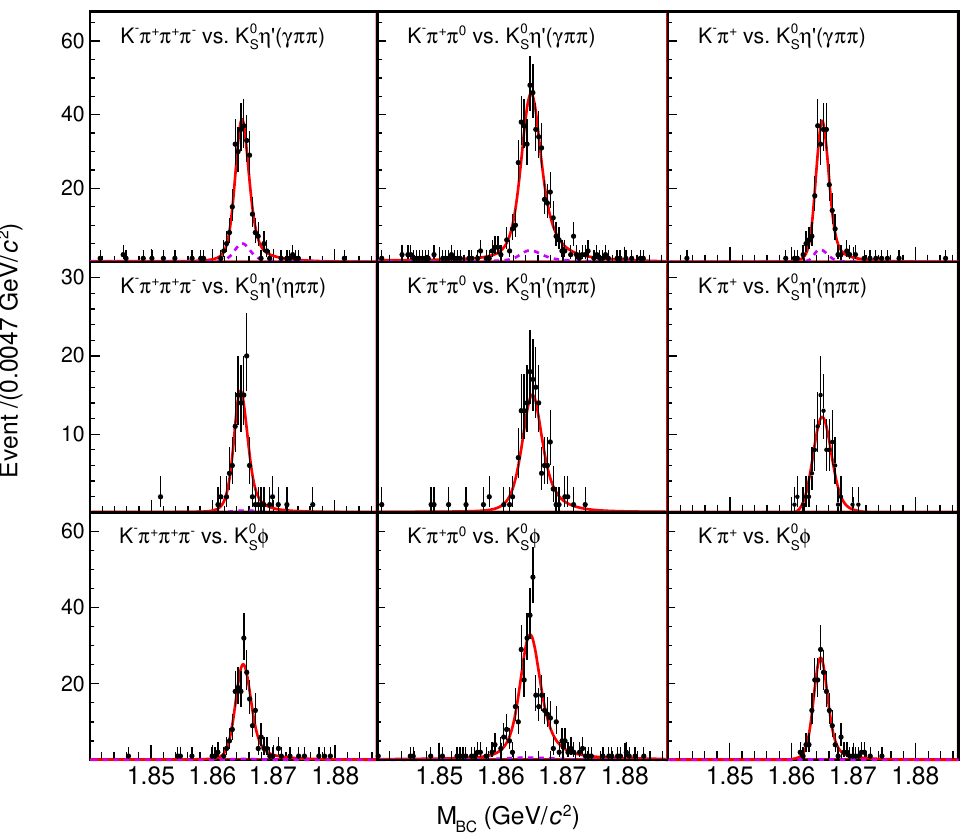
Figure 14 . M BC distributions for decays tagged by the modes D → K 0 K 0 η 0 ( ηπ + π − ) and D → K 0 φ . The points with error bars are data; the dashed purple line shows S S the peaking-background contributions; the combinatorial-background contribution is at too low a level to be